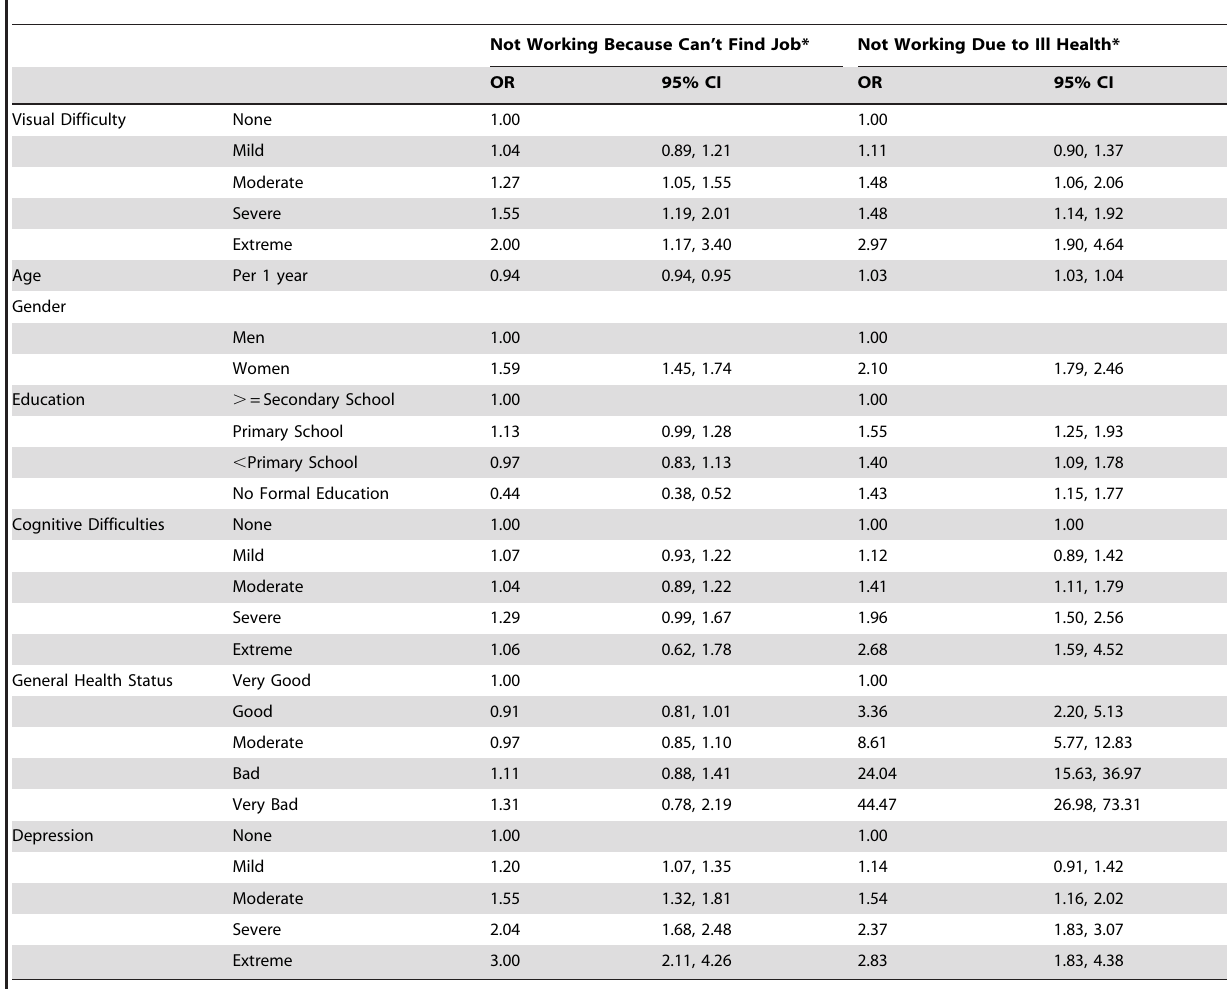
Table 3. Multiple multinomial regression results of relationship between visual difficulty and unemployment.